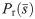
Reduced maximum-entropy model.(A) Red, solid: Probability distribution for the population-averaged activity, Pr(s¯) given by the reduced model for our dataset Eq (15); note the two probability maxima. Blue, dashed: empirical frequency distribution of the population-averaged activity from our dataset. (B) Population-averaged activities s¯(t) obtained from several instances of the Glauber dynamics associated with the reduced model, with homogeneous couplings, Jij = Jr, and biases, hi = hr, of Eq (16). As in Fig 3, each instance starts with an initial population activity s(0) having different values of population average s¯(0), and is represented by a different red shaded curve. The initial values range from Ns¯(0)=0 (light red) to Ns¯(0)=N (dark red).